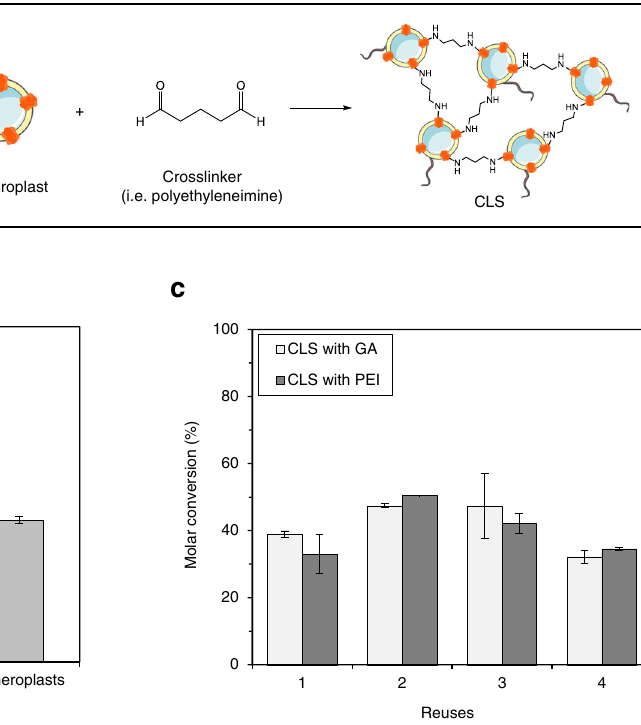
Fig. 5 | Crosslinked spheroplasts (CLS) as biocatalysts or for the cyclization of geranyl acetone 1 E/Z . a Scheme of the crosslinking of the proteins located on the cytoplasmatic membrane. Glutaraldehyde crosslinking is depicted. Graphical representations contain modi fi ed Servier Medical Art images (smart.servier.com). b BiotransformationsinbatchwithCLScrosslinkedwitheitherGA(glutaraldehyde) or PEI (polyethyleneimine). Reactions were performed in 1mL of 2mM geranyl acetone 1 E/Z , 2mM cyclodextrin, 0.2% SDS and 20mM citric acid buffer at pH 6.0